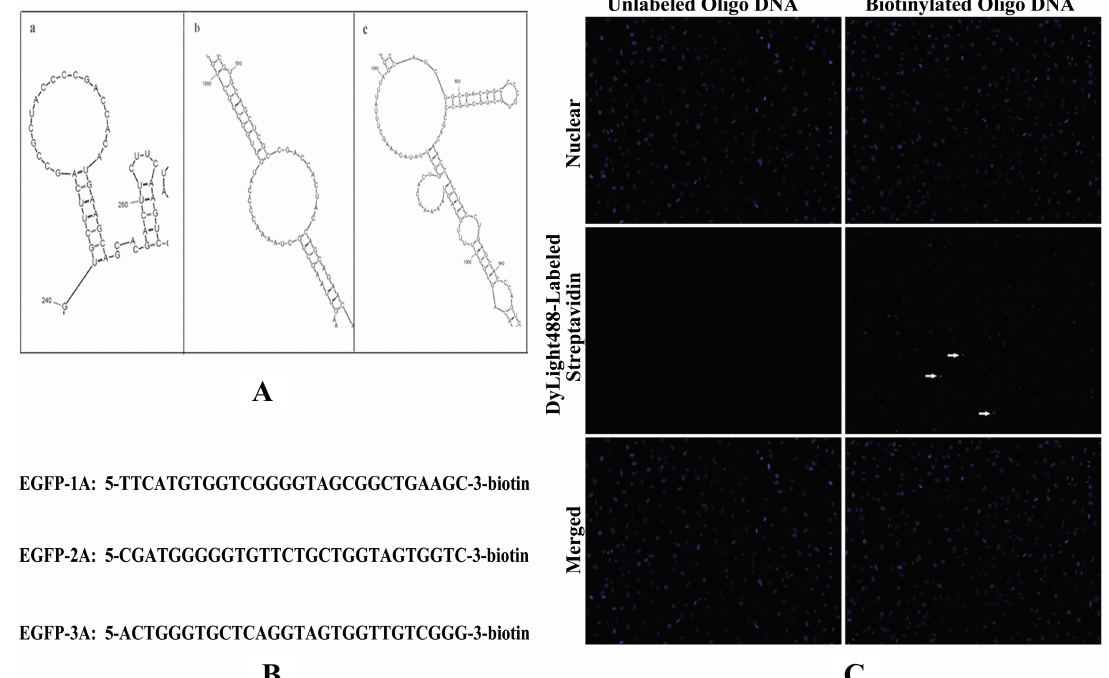
Figure 3. Antisense oligo DNAs of EGFP mRNA were labeled with biotin. ( A ) The secondary structures of the EGFP mRNA were predicted by software M-Fold; ( B ) The sequence of antisense oligo DNA targeting to EGFP mRNA were biotinylated at 3'-end; and ( C ) Biotinylated oligo DNA were detected by fluorescent microscope through Dylight